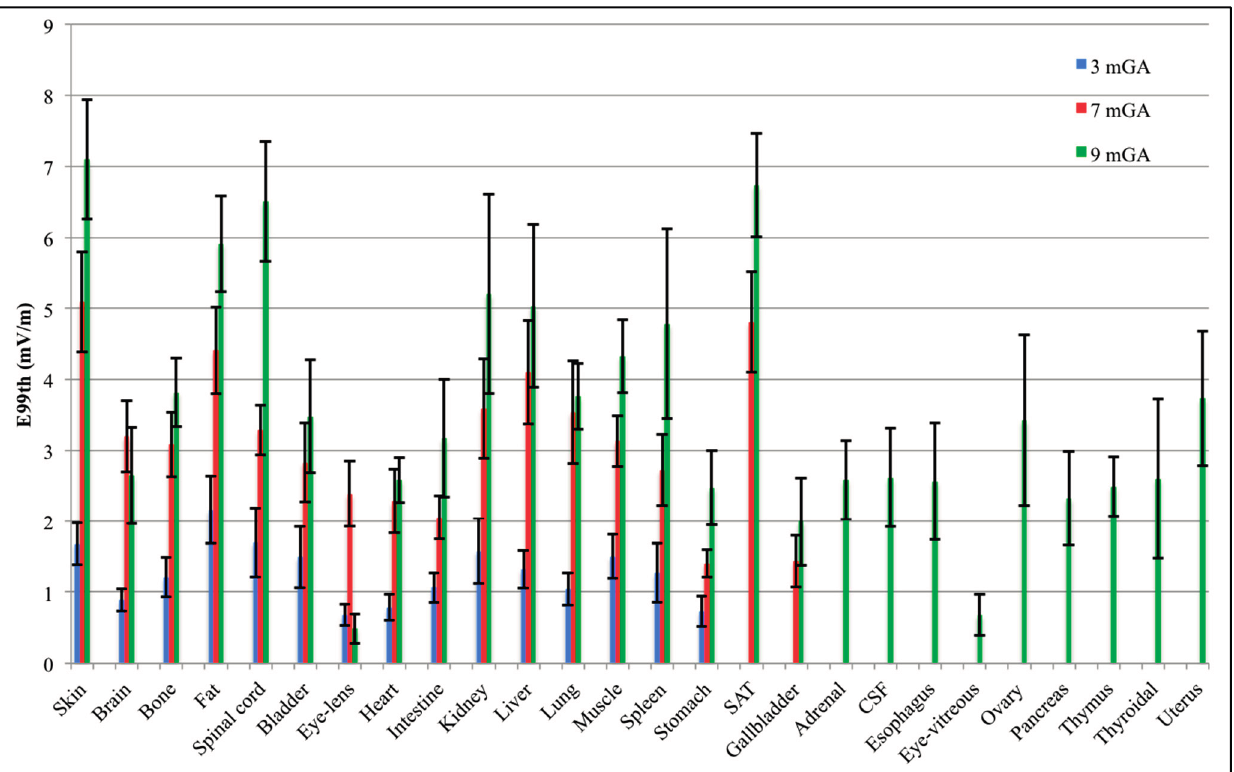
Figure 3. Mean value (bar) and standard deviation (whiskers) of E 99th in each fetal tissue at 3, 7 and 9 months